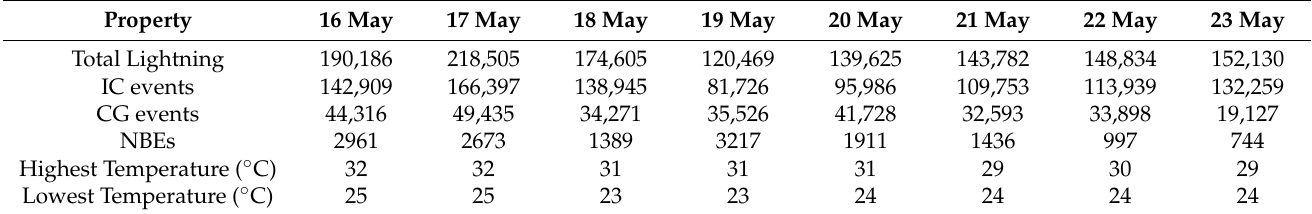
Table 1. Total lightning data and the environment temperature during 16–23